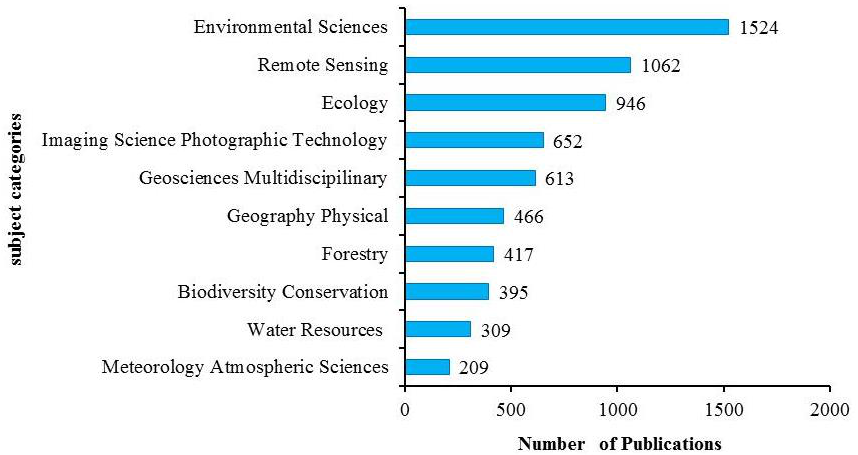
Figure 2. Top 10 subject categories in the field of the remote sensing monitoring of protected areas (PAs).